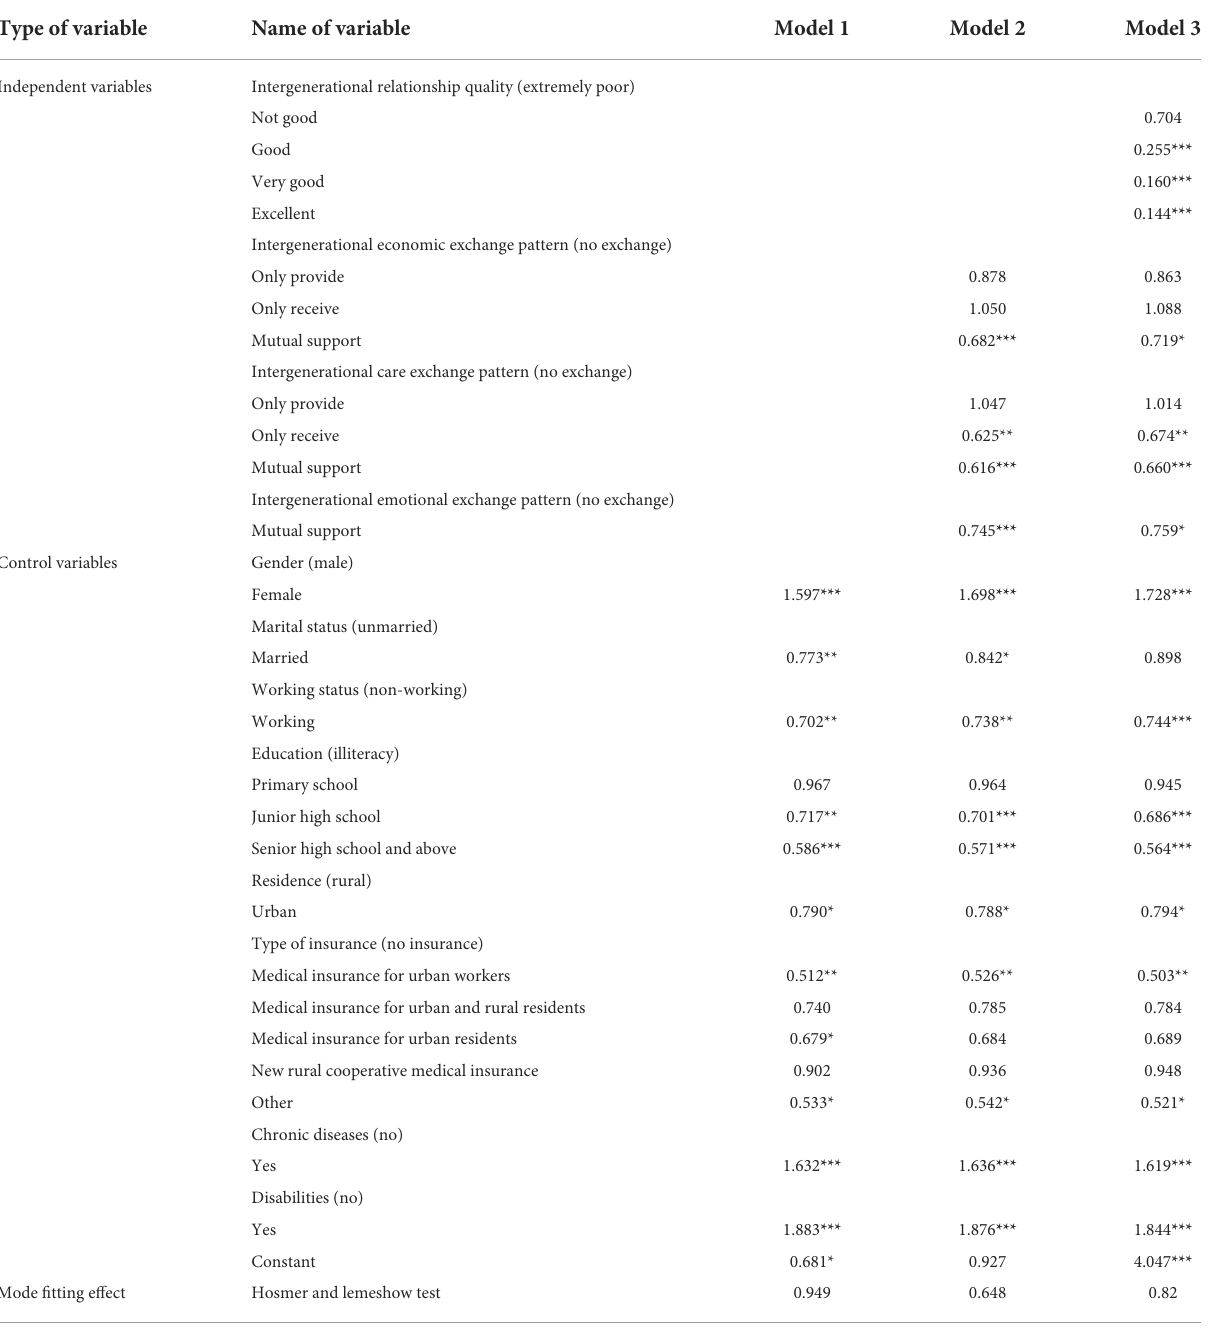
TABLE 6 Analysis of the relationship between intergenerational relationship quality and intergenerational exchange patterns and the depressive symptoms in the elderly ( n =